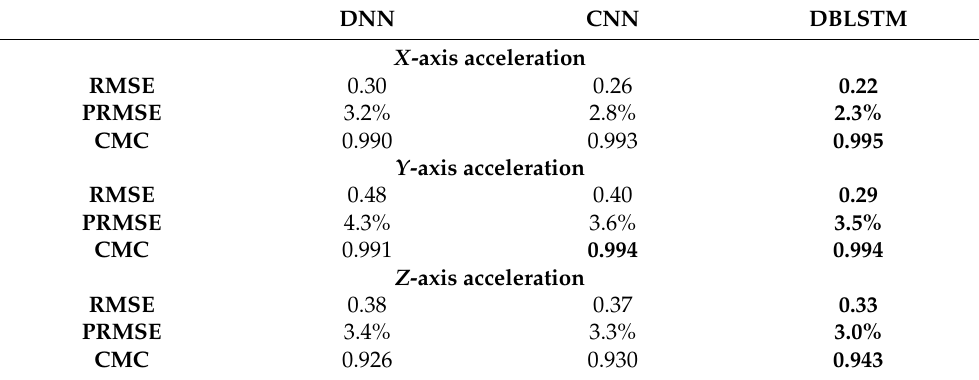
Table 2. Details for model performance comparison. Note that the best performances are marked in